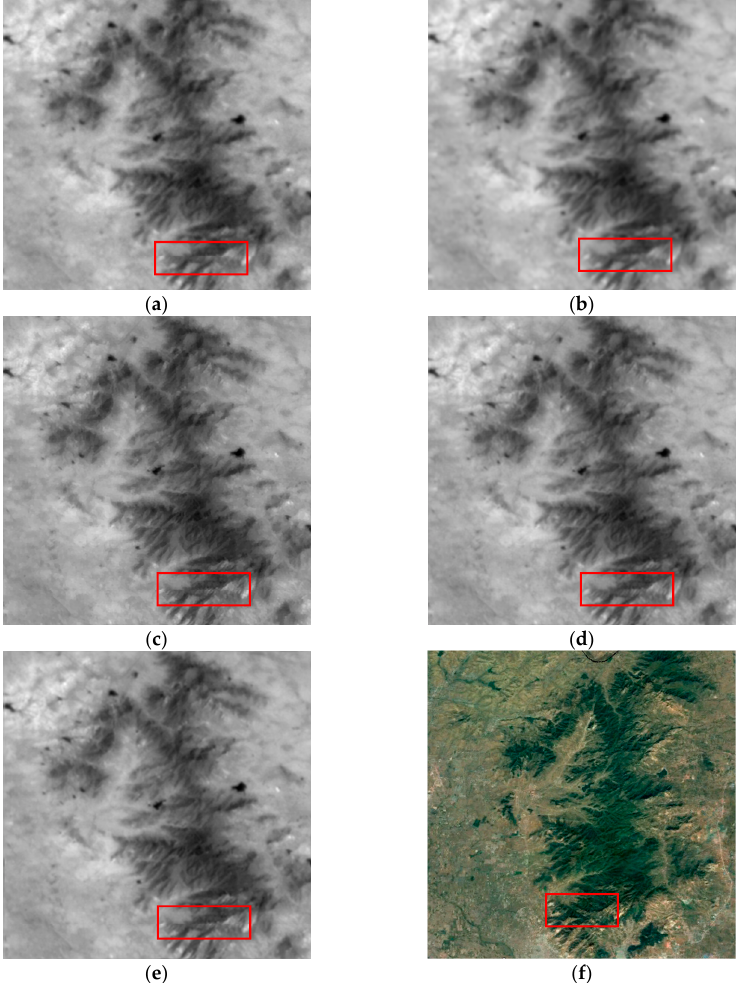
Figure 7. Experimental results of the hilly area. ( a ) The bicubic upsampled reference image; ( b ) the added image after registration; the HR images reconstructed by ( c ) the proposed method, ( d ) IBP and ( e ) Farsiu’s algorithm; ( f ) the image chipped from Google Earth.